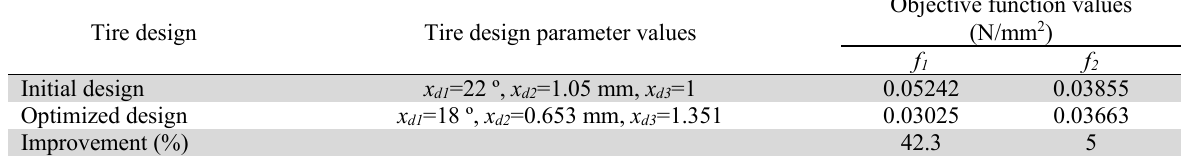
Objective function values (N/mm 2